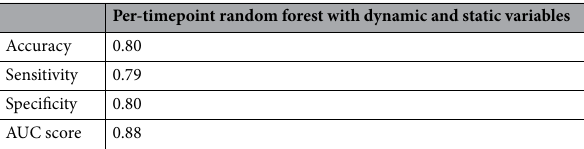
Table 2. Model metrics for per-timepoint random forest.